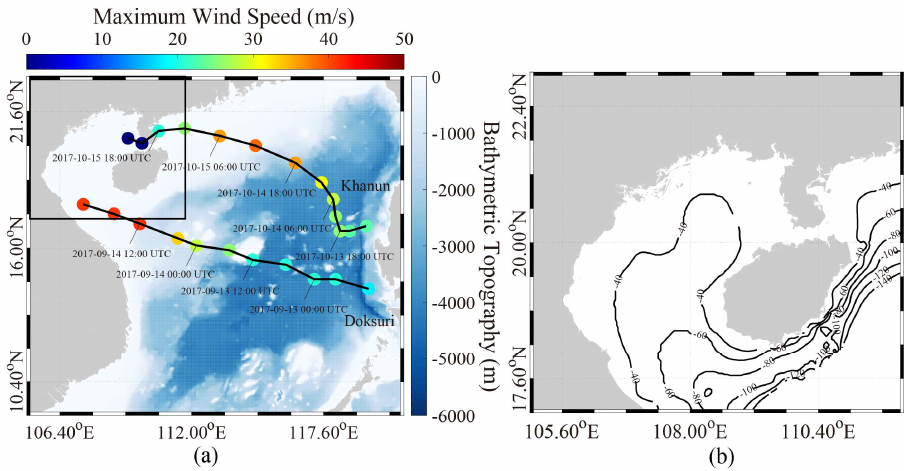
Figure 1. ( a ) the bathymetric topography of the South China Sea, in which the black lines represent the track of typhoons Doksuri and Khanun, and the colored points represent the maximum wind speed of typhoons. The area inside the black rectangular box is the geographic location of the analyzed area; ( b ) the bathymetric topography of the analyzed area corresponds to the black rectangular box in Figure 1a.